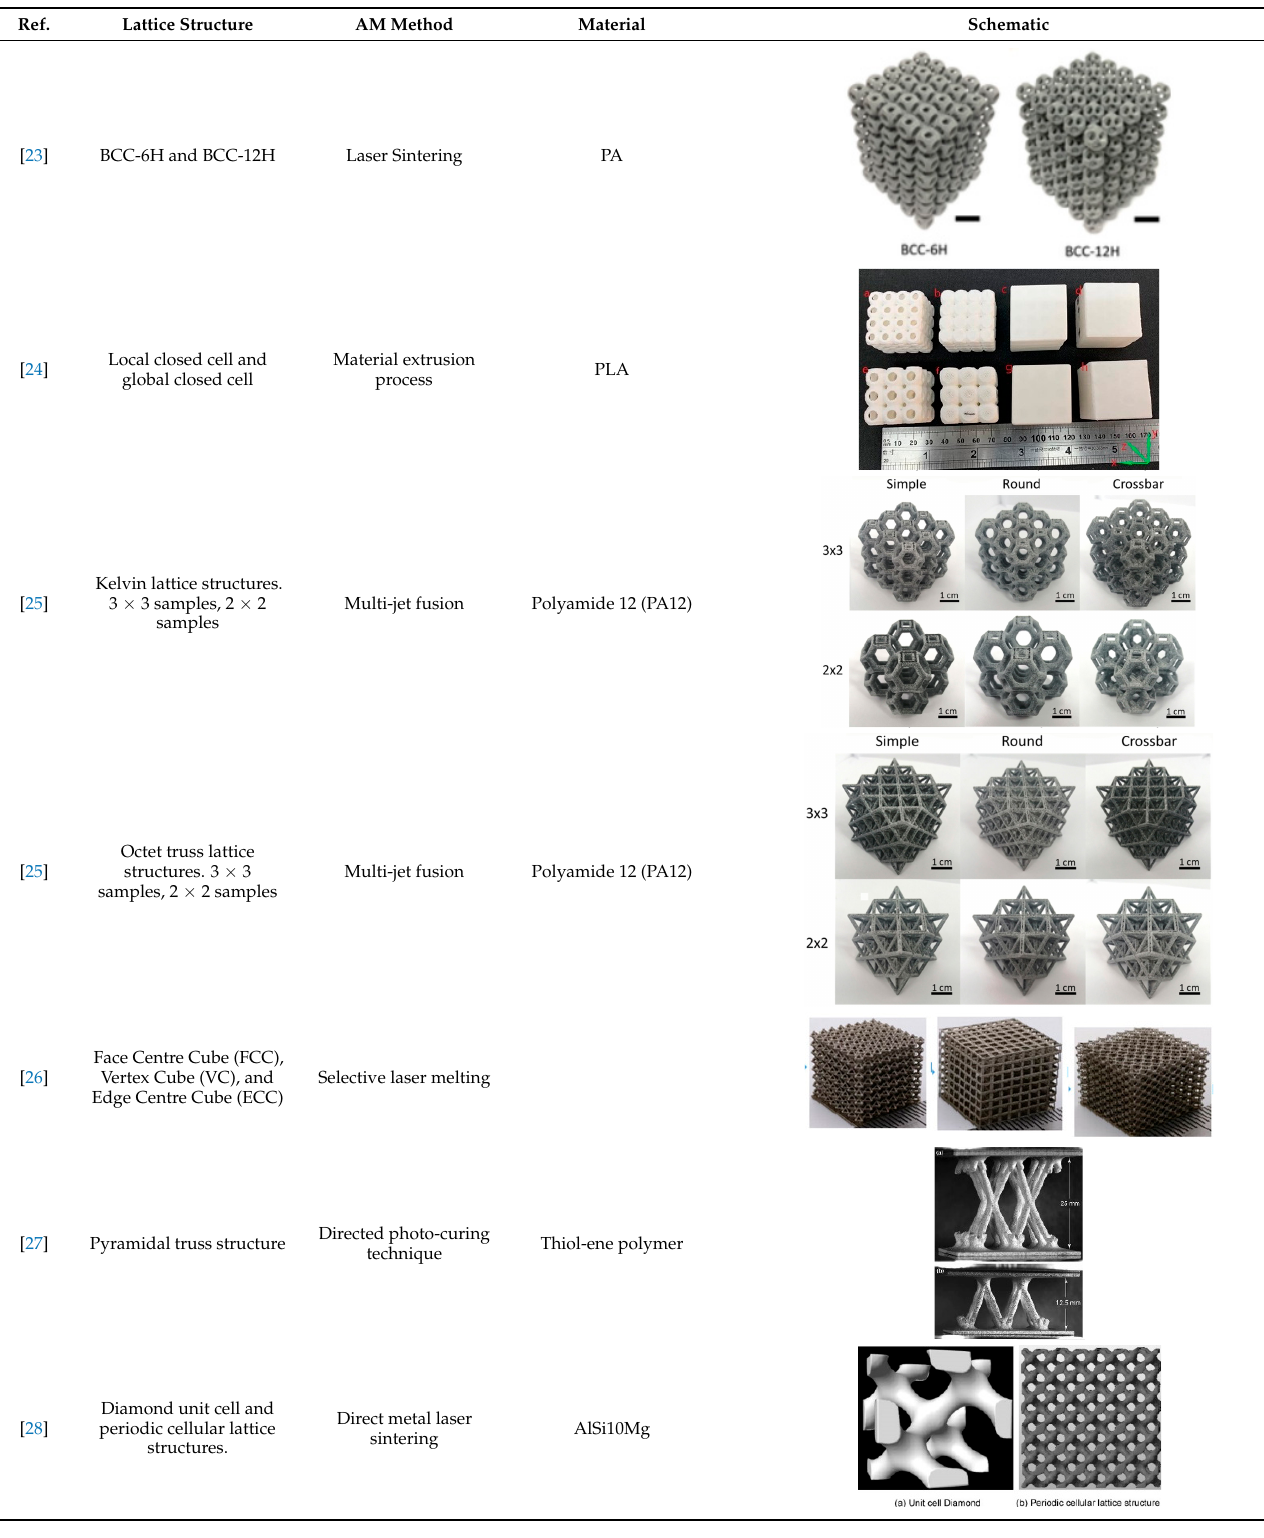
Pyramidal truss structure